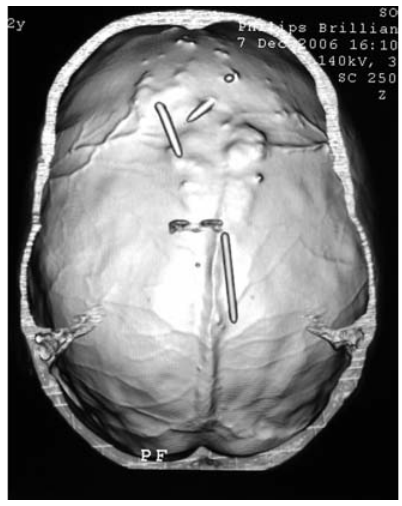
Figure 2. Three dimensional brain tomogra- phy showing the position of the 3 needles.